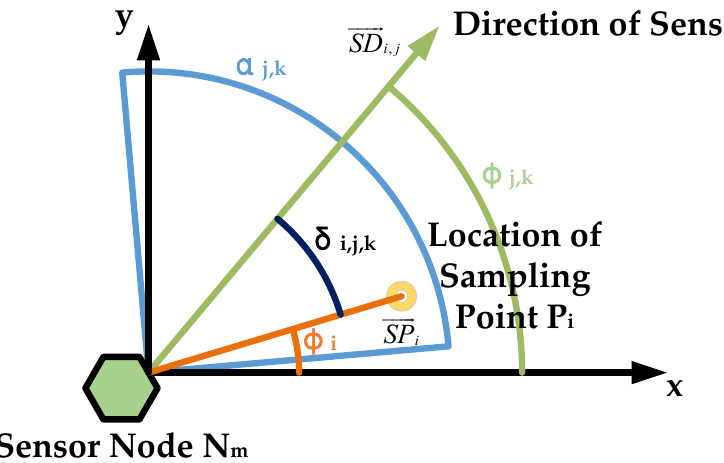
Figure 2. The coverage area of the directional